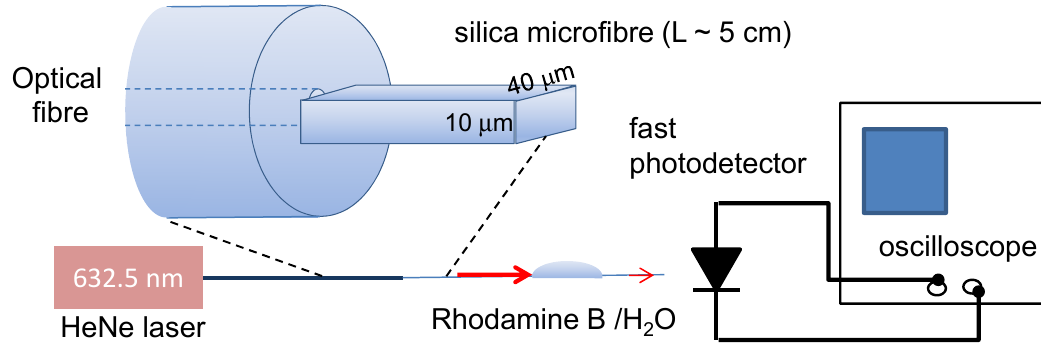
Figure 4. Schematic of the optical transmission measurement through the microfibre with a drop of Rhodamine B containing water. The coupling area between standard fibre and slab microfiber is zoomed in for